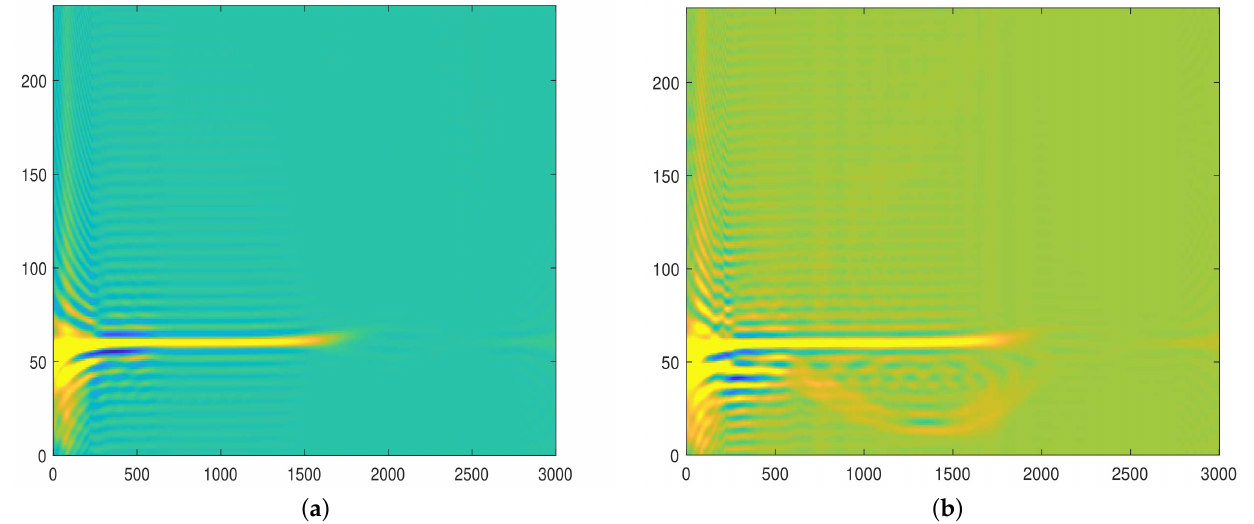
Figure 7. Wigner–Ville distribution for healthy and faulty currents. ( a ) Healthy; ( b ) one broken bar.